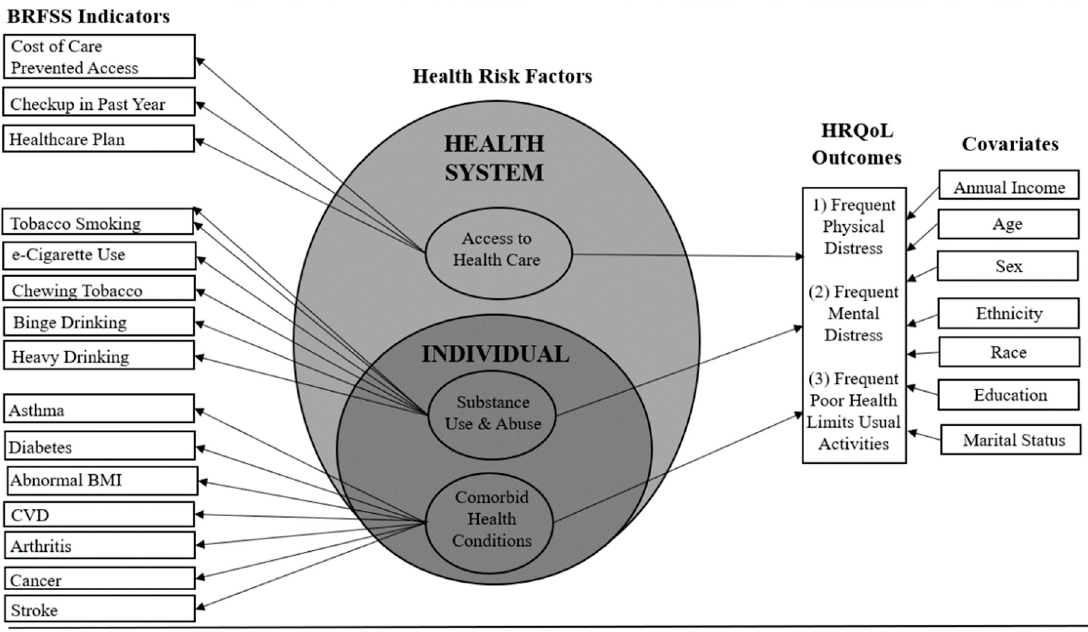
Figure 1. LCM approach to analyze 2016 and 2017 BRFSS data collected from employed adults with COPD living in KY, NC, TN, and WV (N = 1326). Fifteen indicators, three domains at two social ecological levels (i.e., individual, health system), three HRQoL outcomes, seven covariates. Data in this figure ARE adapted based on the indicators, domains, and covariates tested by Jiang and Zack [31] and Stellefson et al. [27].